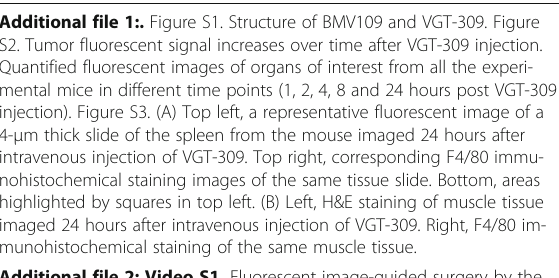
Additional file 1:. Figure S1. Structure of BMV109 and VGT-309. Figure S2. Tumor fluorescent signal increases over time after VGT-309 injection. Quantified fluorescent images of organs of interest from all the experi- mental mice in different time points (1, 2, 4, 8 and 24 hours post VGT-309 injection). Figure S3. (A) Top left, a representative fluorescent image of a 4- μ m thick slide of the spleen from the mouse imaged 24 hours after intravenous injection of VGT-309. Top right, corresponding F4/80 immu- nohistochemical staining images of the same tissue slide. Bottom, areas highlighted by squares in top left. (B) Left, H&E staining of muscle tissue imaged 24 hours after intravenous injection of VGT-309. Right, F4/80 im- munohistochemical staining of the same muscle tissue.